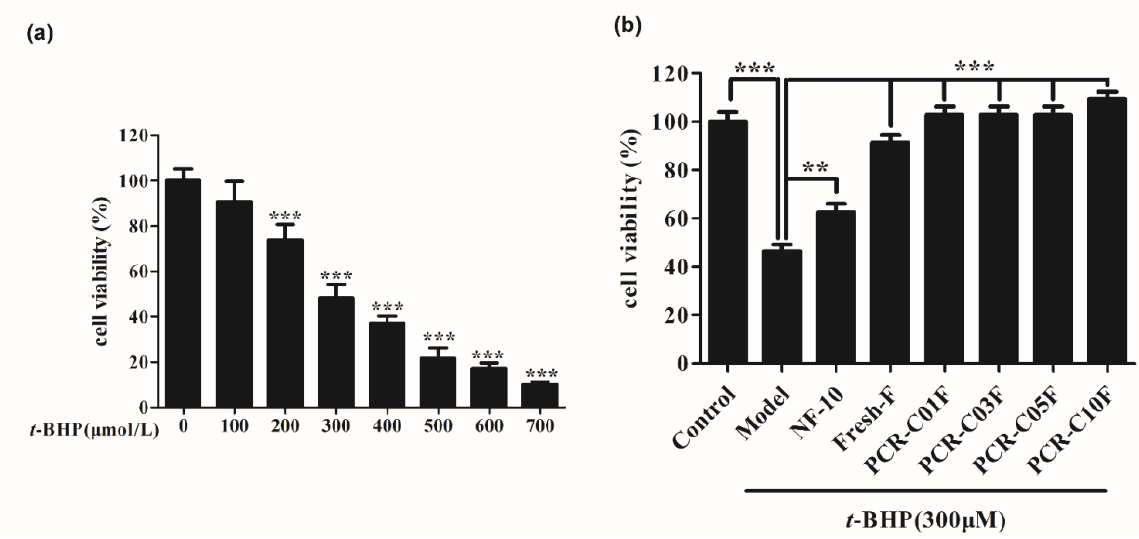
Figure 5. Effect of t -BHP on cell viability and protective effects of PCR-C of different storage periods, Fresh and NF on t -BHP-induced cytotoxicity. ( a ) HepG2 cells were treated with t -BHP (0–700 µ M) for 3h and cell viability was analyzed by MTT assay. ( b ) HepG2 Cells were pretreated with 50 µ g/mL NF-10, Fresh, PCR-C01, PCR-C03, PCR-C05, and PCR-C10 for 24h prior to exposure to t -BHP (300 µ M) for 3 h, then cell viability was determined by MTT assay. Results are presented as mean ± SD, n = 6. ** p < 0.01, *** p < 0.001 vs. control